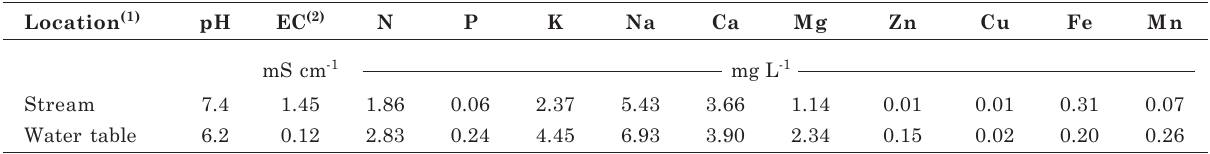
Table 4. Chemical characteristics of stream water and water from the soil water table solution of areas with great incidence of ESBVRD